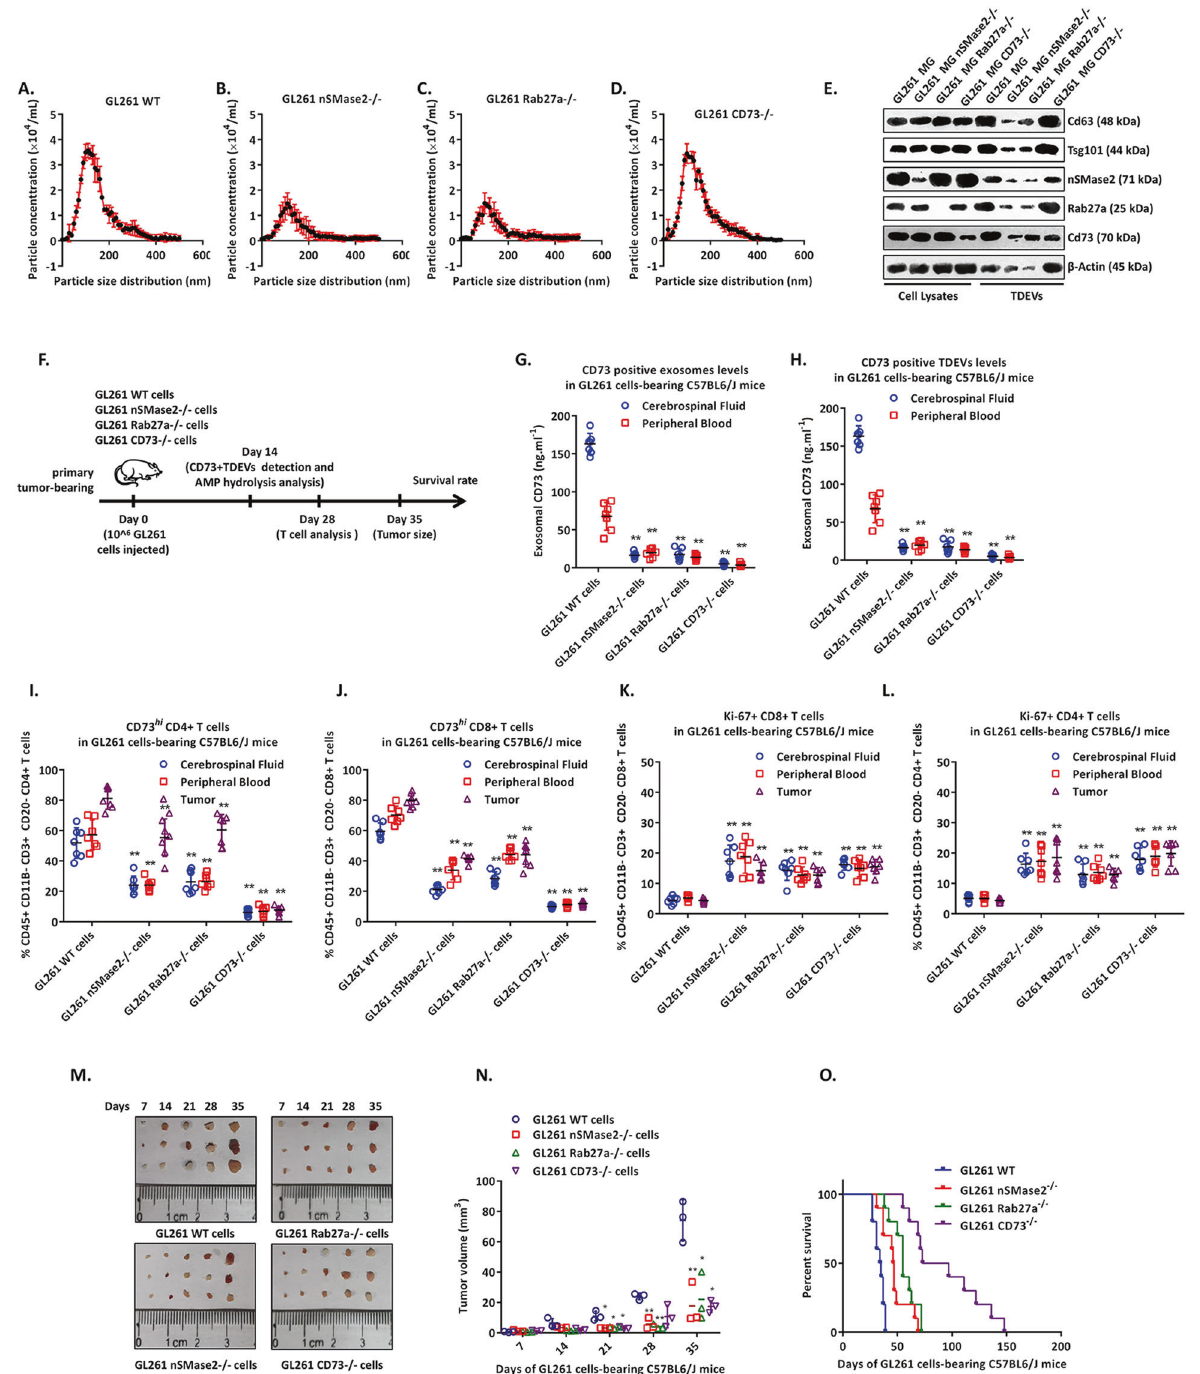
Fig. 5 The elimination of CD73-positive TDEVs inhibits the proliferation of GBM cells in vivo. A – D The count and size of TDEVs in the culture supernatant of WT, nSMase2 − / − , Rab27a − / − and CD73 − / − GL-261 cells were detected by nanoparticle tracking analysis. E Representative immunoblot of the expression of exosome markers (CD63 and TSG101), nSMase2, Rab27a and CD73 in cell lysates and TDEVs of WT, nSMase2 − / − , Rab27a − / − and CD73 − / − GL-261 cells. F Experimental protocol for mice bearing WT, nSMase2 − / − , Rab27a − / − or CD73 − / − GL-261 cell-derived tumours. G The levels of CD73-positive TDEVs in the cerebrospinal fl uid and peripheral blood of WT, nSMase2 − / − , Rab27a − / − and CD73 − / − GL-261 tumour-bearing mice ( n = 6). H Adenosine levels in the cerebrospinal fl uid and peripheral blood of WT, nSMase2 − / − , Rab27a − / − and CD73 − / − GL-261 tumour-bearing mice ( n = 6). I – L The percentage of CD73 hi CD4 + , CD73 hi CD8 + , Ki67 + CD4 + and Ki67 + CD8 + T cells in the cerebrospinal fl uid, peripheral blood and tumours of WT, nSMase2 − / − , Rab27a − / − and CD73 − / − GL-261 tumour- bearing mice ( n = 6). M , N The tumour volume in mice bearing WT, nSMase2 − / − , Rab27a − / − or CD73 − / − GL-261 cell-derived tumours at 7, 14, 21, 28 and 35 days after implantation (M) ( n = 3). O Survival curve of tumour-bearing mice inoculated with WT, nSMase2 − / − , Rab27a − / − or CD73 − / − GL-261 cells ( n = 10). Data are shown as the mean ± SD; t test, * p < 0.05 and ** p < 0.01.